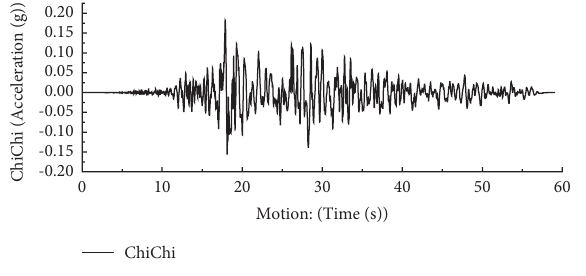
Figure 2: Acceleration time history of Chichi motion.